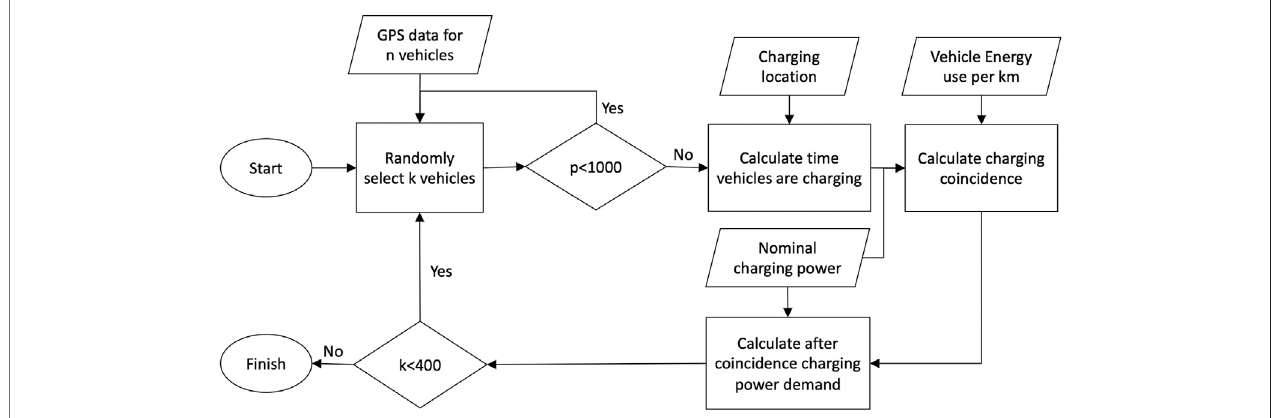
FIGURE 1 | Flowchart of the process to calculate after-coincidence charging power demand from the GPS measured driving behavior.